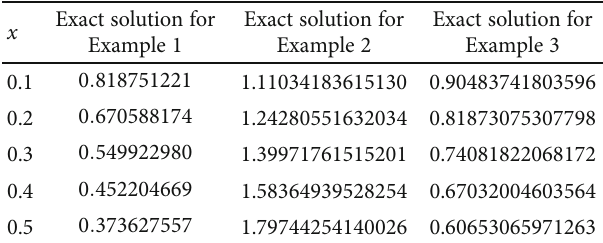
Table 7: Exact solutions for Example 1, Example 2, and Example 3. x Exact solution for